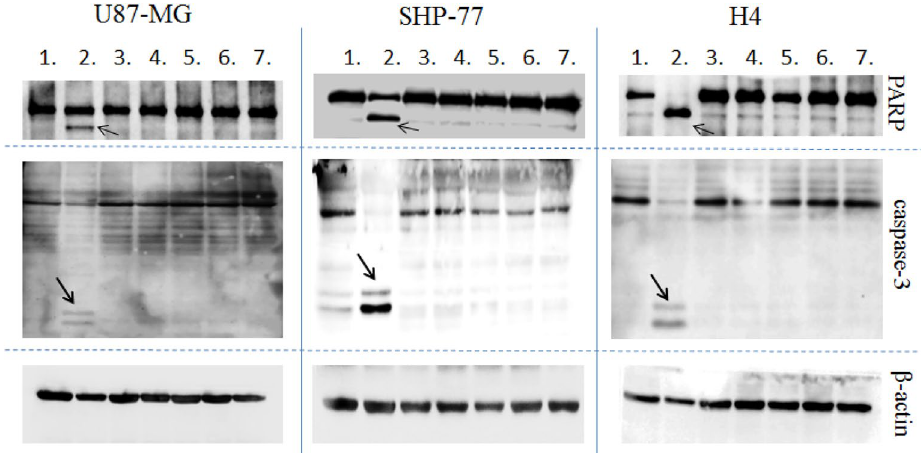
Figure 5. The effects of B1R antagonists and cisplatin on the expression levels of caspase-3 and PARP cleavage in cell lines U87-MG, SHP-77, and H4 were determined by Western blotting. 1. control cells; 2. cisplatin (25 μM); 3. BK7 (50 μM); 4. BK3 (50 μM); 5. BK4 (50 μM); 6. BK10 (50 µM); 7. BK11 (50 μM). Arrows indicate the induction of caspase-3 and processed PARP fragments in cells treated with cisplatin as a positive control of apoptosis. After 24 h of cell treatment, no induction of caspase-3 and PARP is seen compared with untreated control cells. Representative Western blot images showing expression of β-actin were used as a reference protein. Each picture represents a vertically cut part of nitrocellulose membranes. The membranes were cut before antibody application, considering the size margin according to the size of the molecular weight